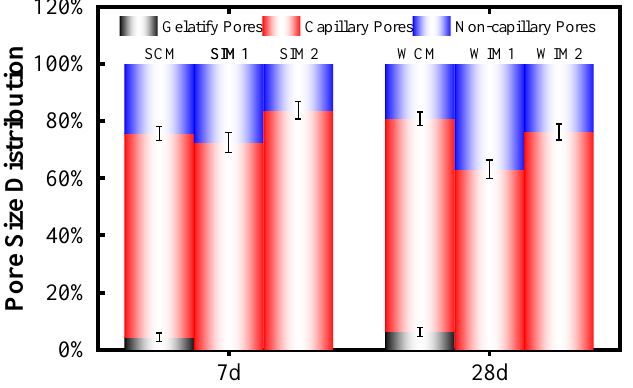
Figure 16. Type distribution of pore size in samples.